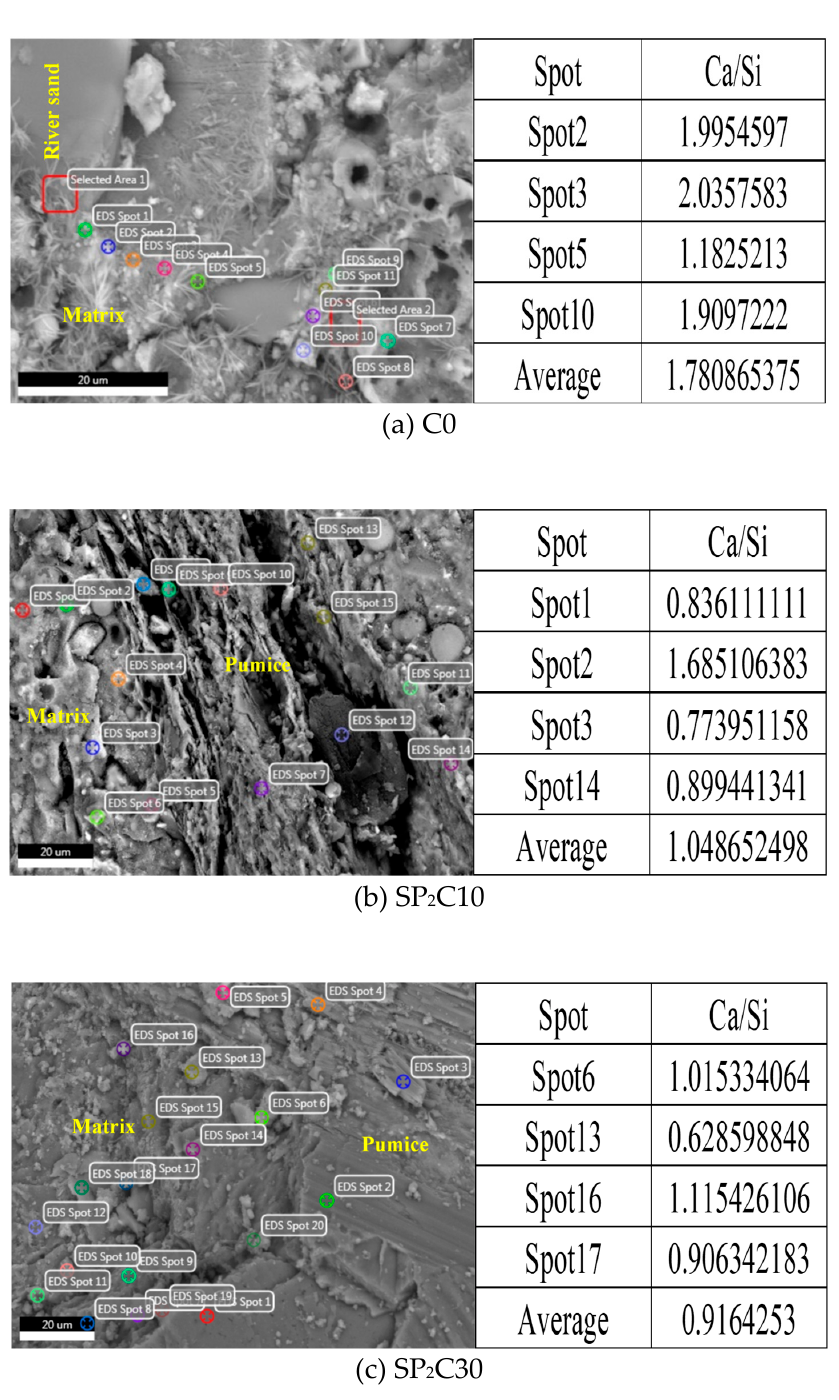
Figure 11. EDS elemental content analysis of the matrix nearby river sand and wet pumice in C0, SP 2 C10, and SP 2 C30 samples mentioned above after 28 d curing: ( a ) C0; ( b ) SP 2 C10; ( c ) SP 2 C30.